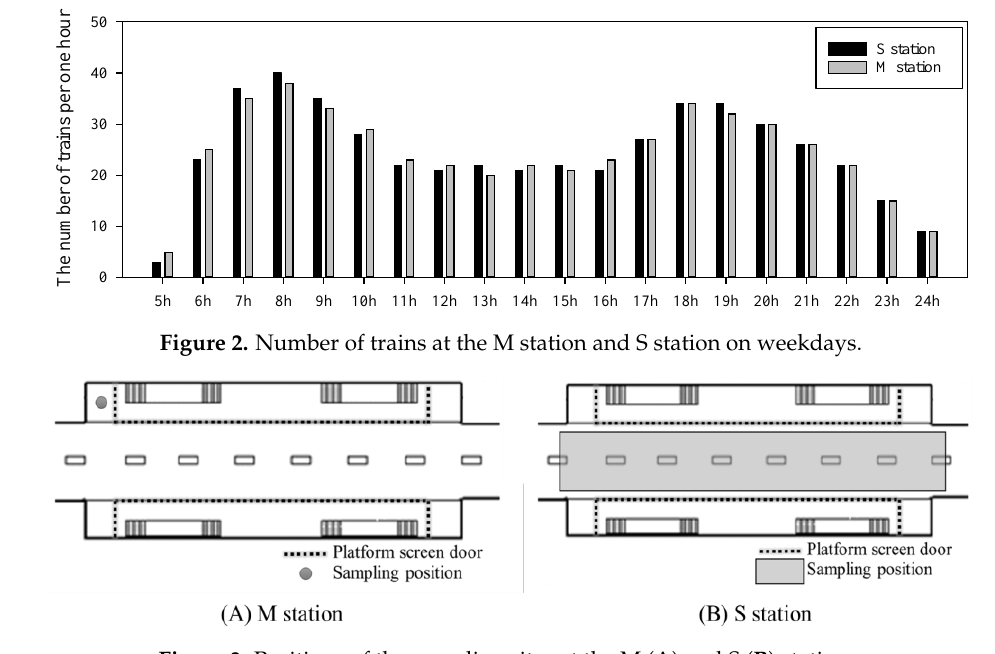
Figure 3. Positions of the sampling sites at the M ( A ) and S ( B ) stations.